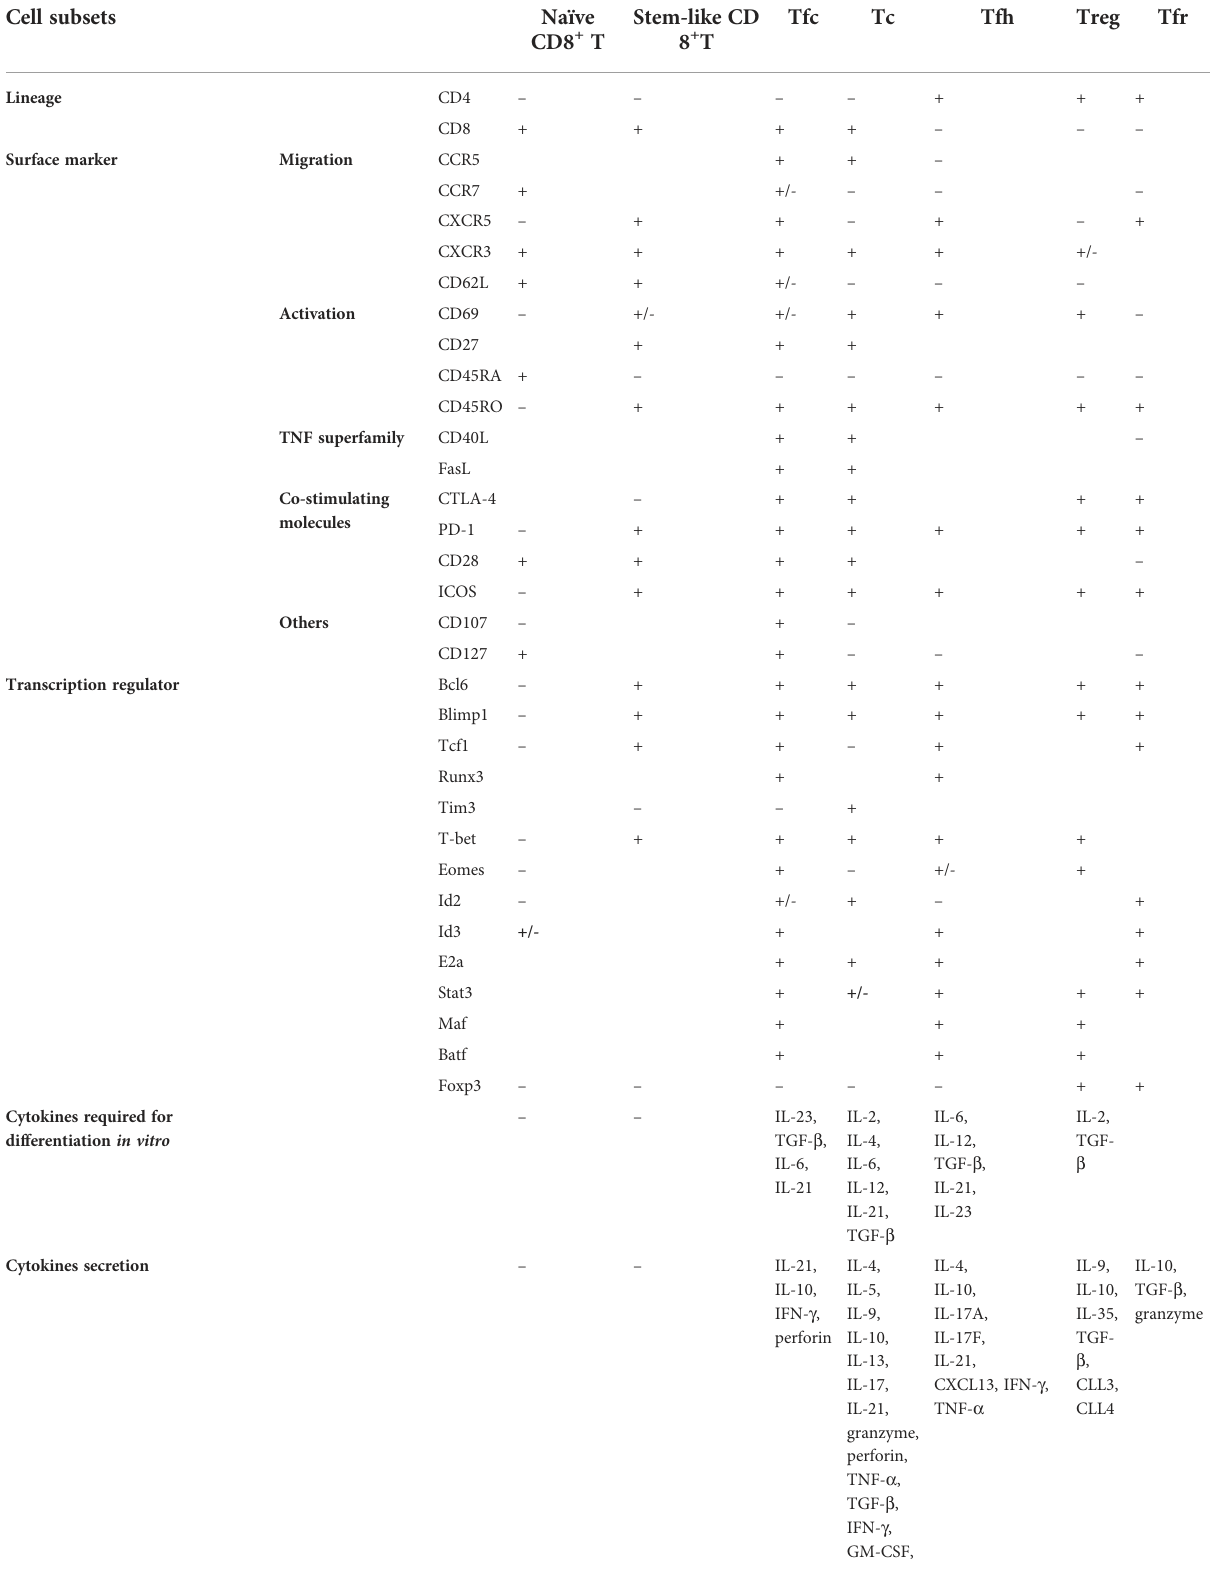
TABLE 1 Comparison among Tfc cell and other T cell